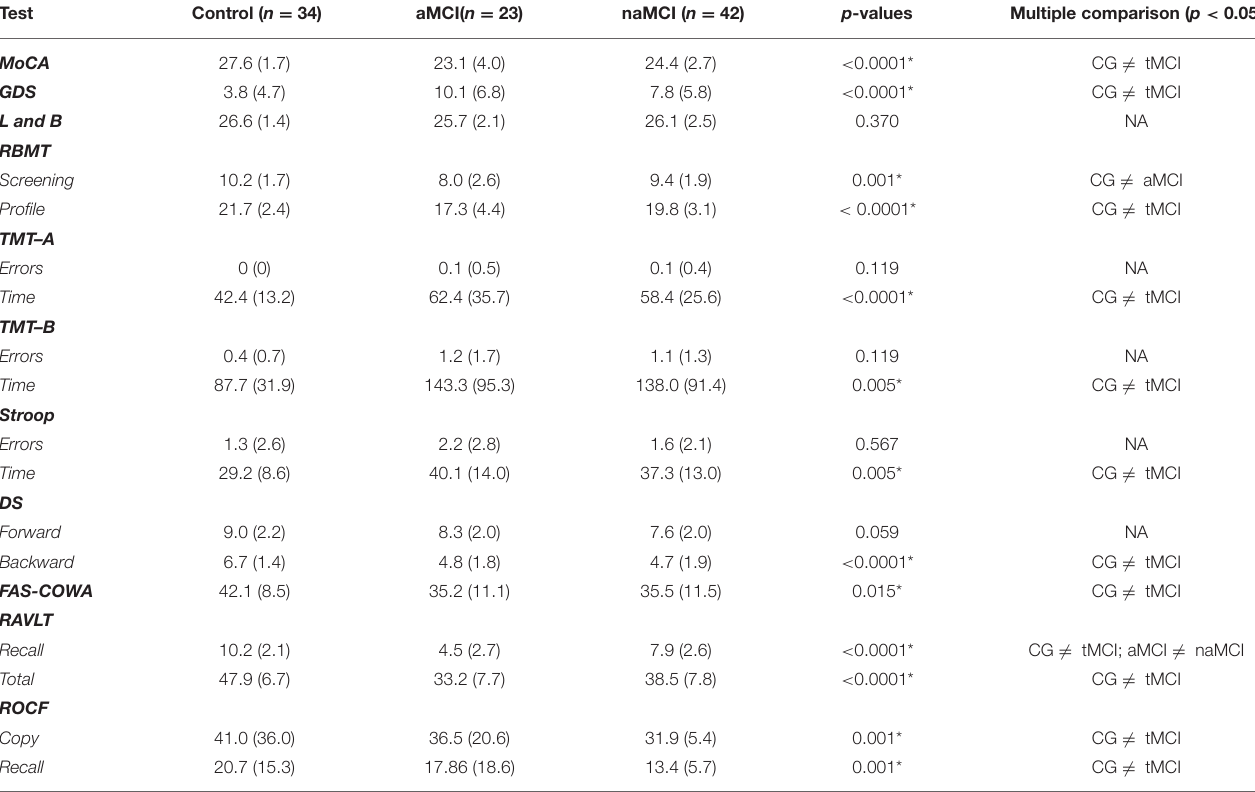
TABLE A1 | Neuropsychological assessment of the